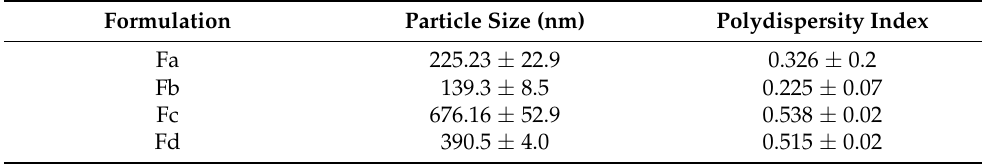
Table 2. The result of optimization blank